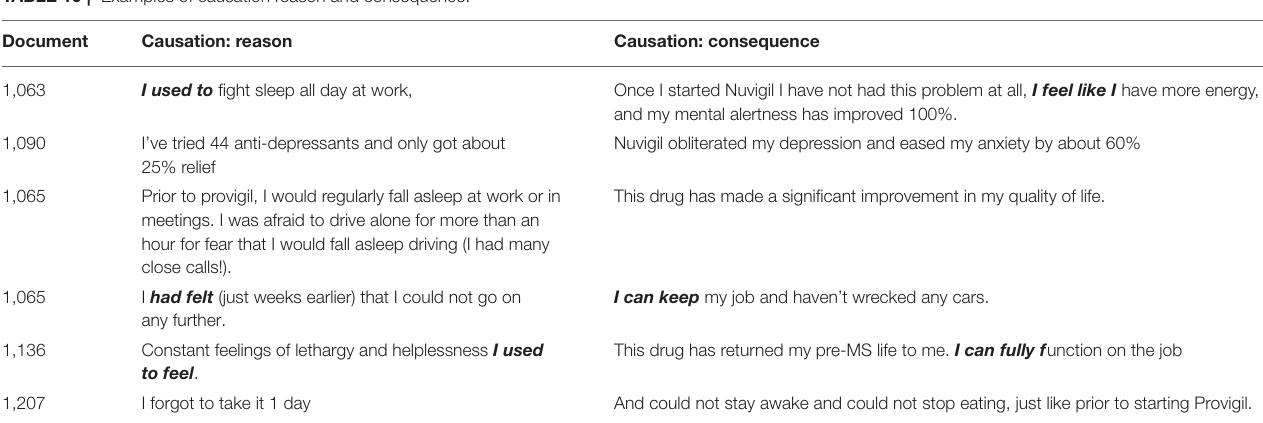
TABLE 10 | Examples of causation reason and